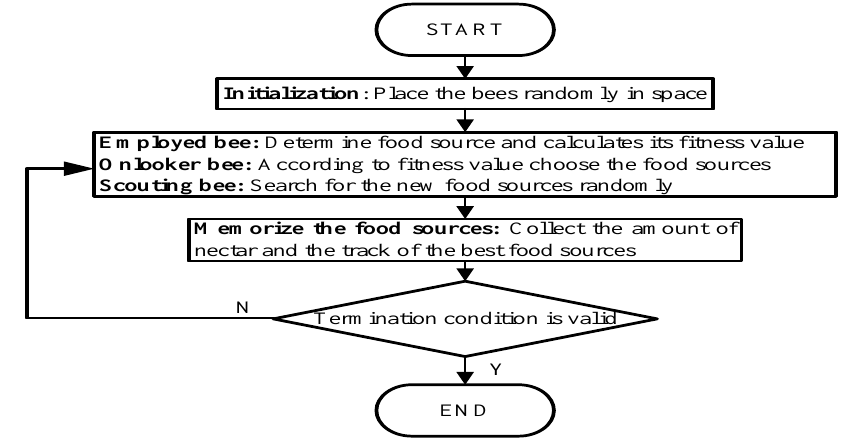
Figure 4. Flowchart of the ABC algorithm.